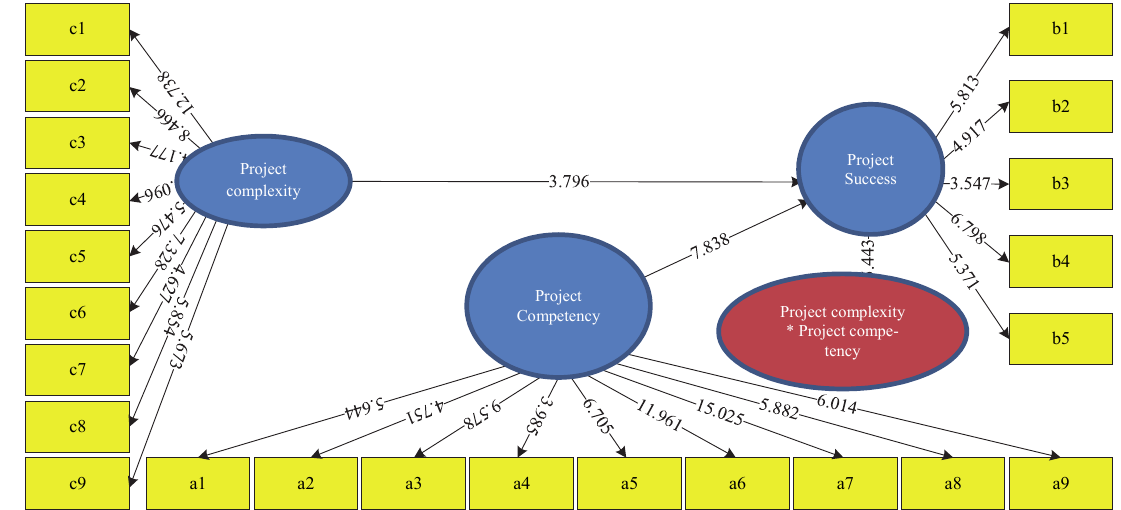
Fig. 2. The relationship between organizational complexity and project success with a moderating role of managerial competence along with meaningful coefficients Z